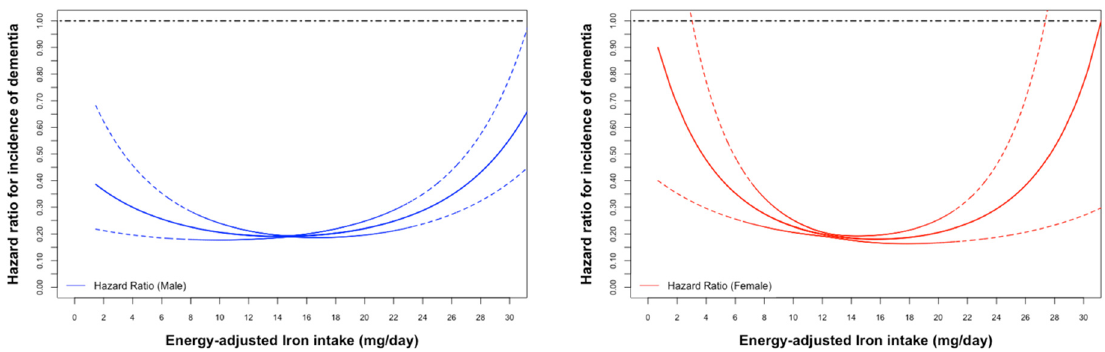
Figure 2. Age-adjusted Cox proportional hazard ratios (HR) (male: blue; female: red) for incidence of all-caused dementia associated with energy-adjusted iron intake.